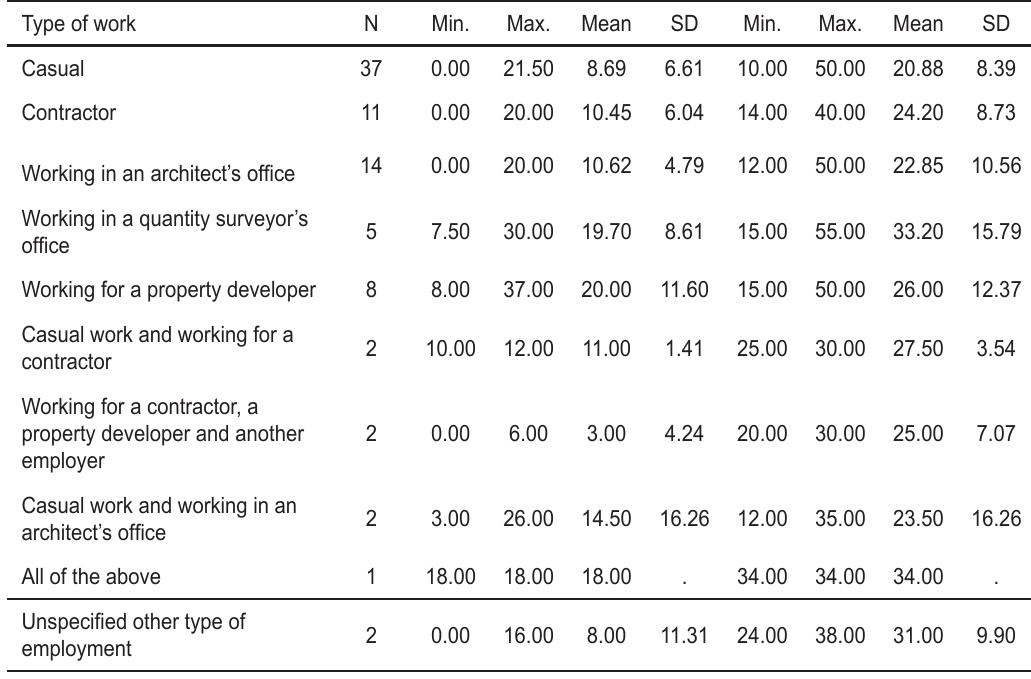
Table 2: Least and most number of hours worked in any week during the last month by type